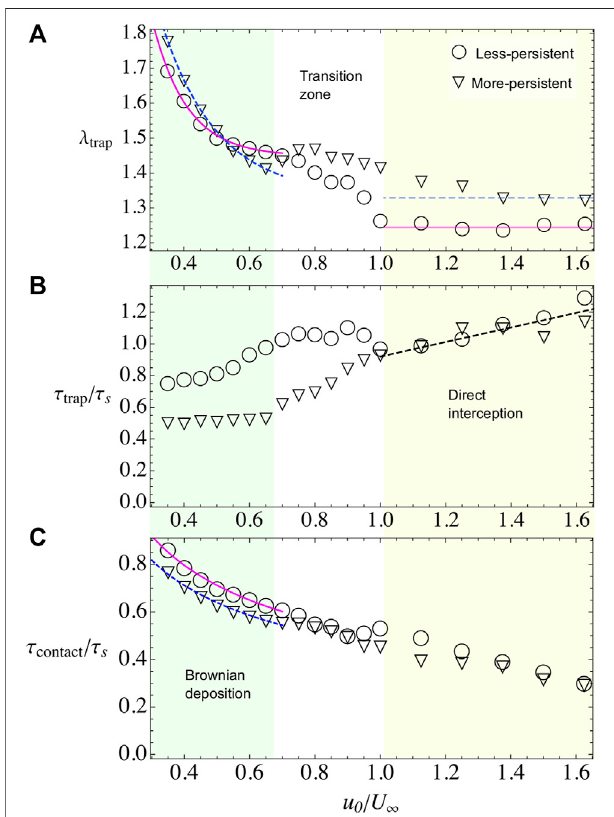
FIGURE 3 | Bacterial adhesion observables when varying the microswimmer ’ s activity u 0 and when U ∞ =40 and R =100. Different symbols represent different microswimmer ’ s types. For less-persistent microswimmers, we use triangles and for more-persistent circles. Two regimes are identi fi ed throughout the observables, Brownian deposition and direct interception , which are indicated by shading color and separated by a white transition zone between them. (A) λ trap for less- and more-persistent microswimmers, respectively. The solid and dashed lines, during Brownian deposition, are phenomenological fi ts with the law λ trap = A (1+ B exp( − C ( u 0 / U ∞ ))). The blurry lines represent a guide to the eye, for the tendency during the direct interception regime. (B) τ trap for less- and more-persistent microswimmers,respectively.Thedashedlineinthedirectinterceptionregime is a phenomenological linear fi t τ trap / τ s = A (1+( u 0 / U ∞ )). (C) The contact time decreases monotonically with the microswimmer ’ s activity. Less-persistent microswimmers spend slightly more time in contact with the surface during the Brownian deposition, while during the direct interception regime the residency time is the same for both microswimmer ’ s